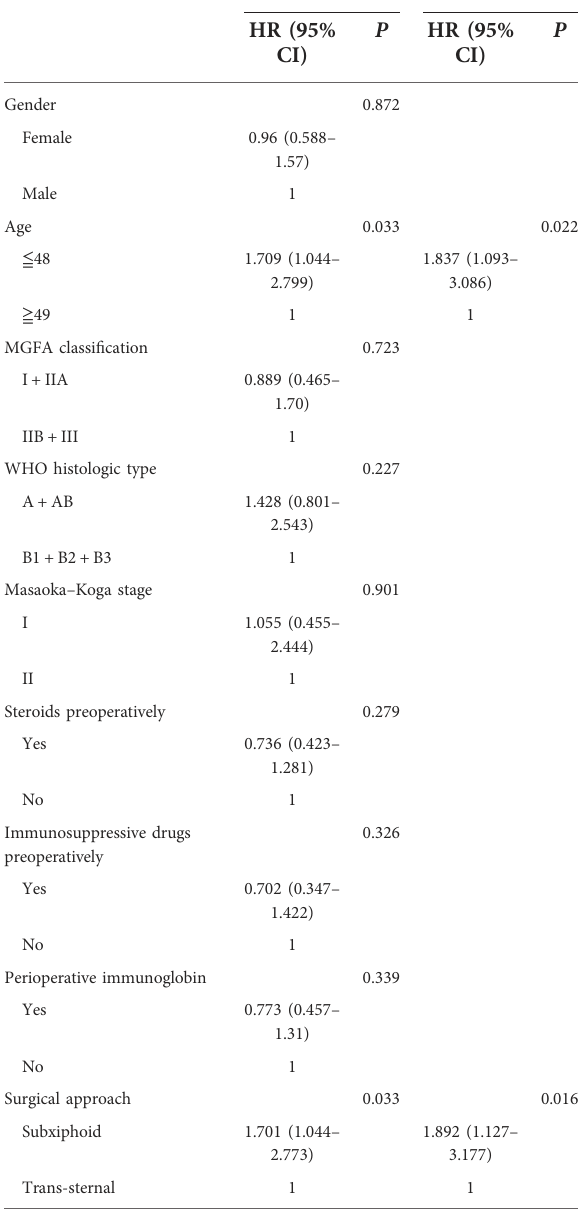
TABLE 3 Univariate and multivariate Cox regression analyses of improved clinical